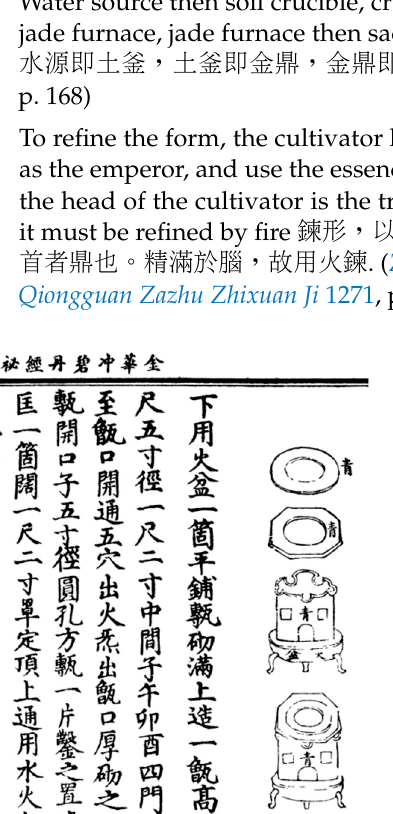
Figure 6. Picture of Zeng 甑 (Bai 1988b, p.